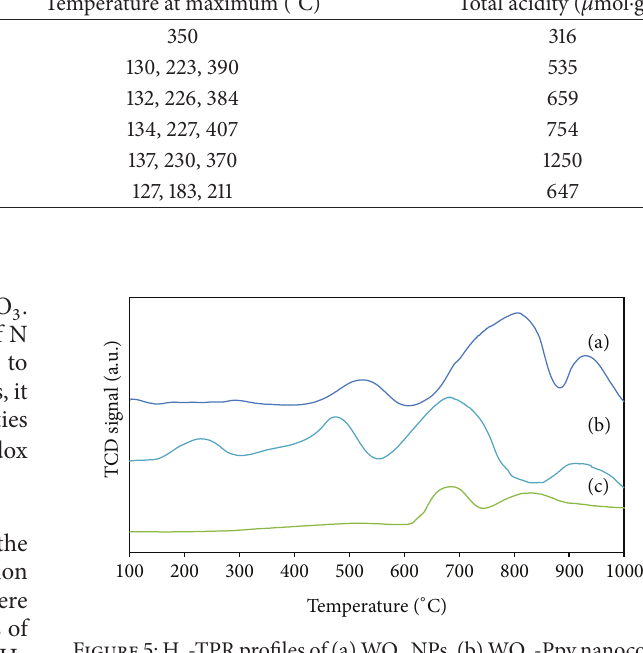
Figure 5: H 2 -TPR profiles of (a) WO 3 NPs, (b) WO 3 -Ppy nanocom- posite, and (c) Pure Ppy.